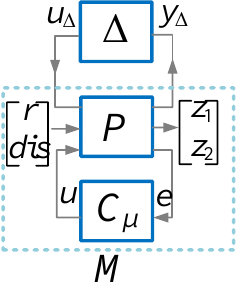
∆ and P– ∆ –C µ Figure 10. M –Δ and P–Δ– C µ configuration. Figure 10. M–